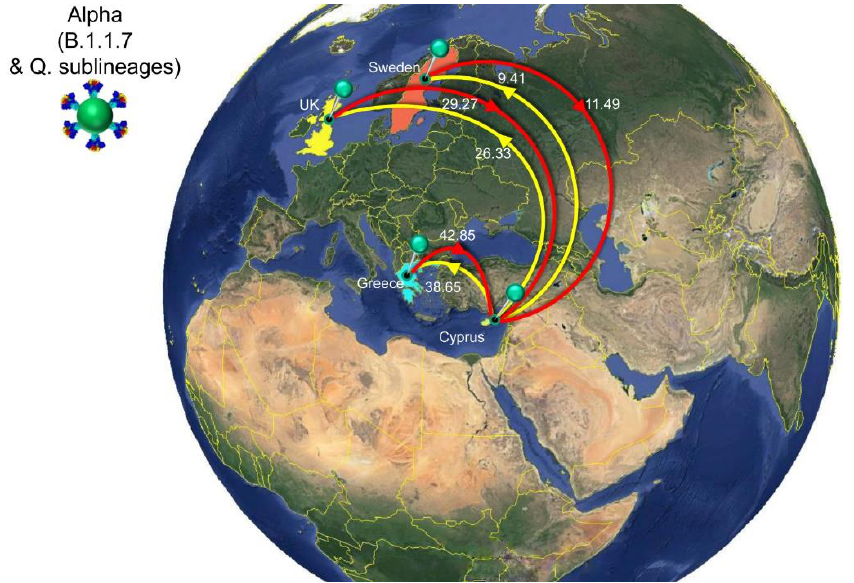
Figure 8. Map of SARS-CoV-2 Alpha (B.1.1.7 & Q. sublineages) transmission between Cyprus and other countries. Geographic origins of SARS-CoV-2 Alpha (B.1.1.7 & Q. sublineages) imported into Cyprus are shown as red lines; exports from Cyprus to other countries are shown as yellow lines. Countries acting as “sources” or “sinks” for SARS -CoV-2 Alpha (B.1.1.7 & Q. sublineages) transmis- sion are highlighted and labeled, and the estimated average number of migration events is indi- cated. To enhance the clarity of the figure, only countries that account for 5% and above of the esti- mated total average number of import or export events are displayed, except if there were fewer